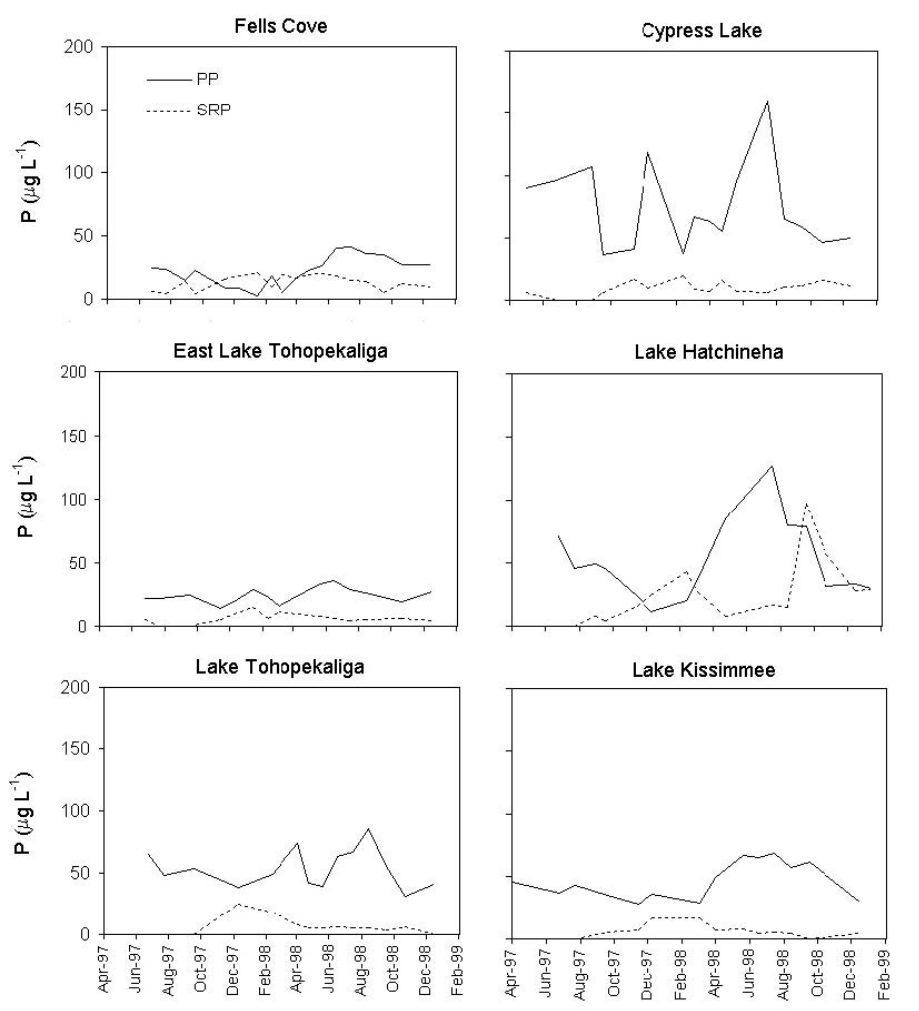
FIGURE 3. Near-surface concentrations of particulate phosphorus (PP) and soluble reactive phosphorus (SRP) concentrations in the Kissimmee Chain-of-Lakes during 1997 and 1998. considerably, and there was a tendency for minimal values of SRP to coincide with maximal values of